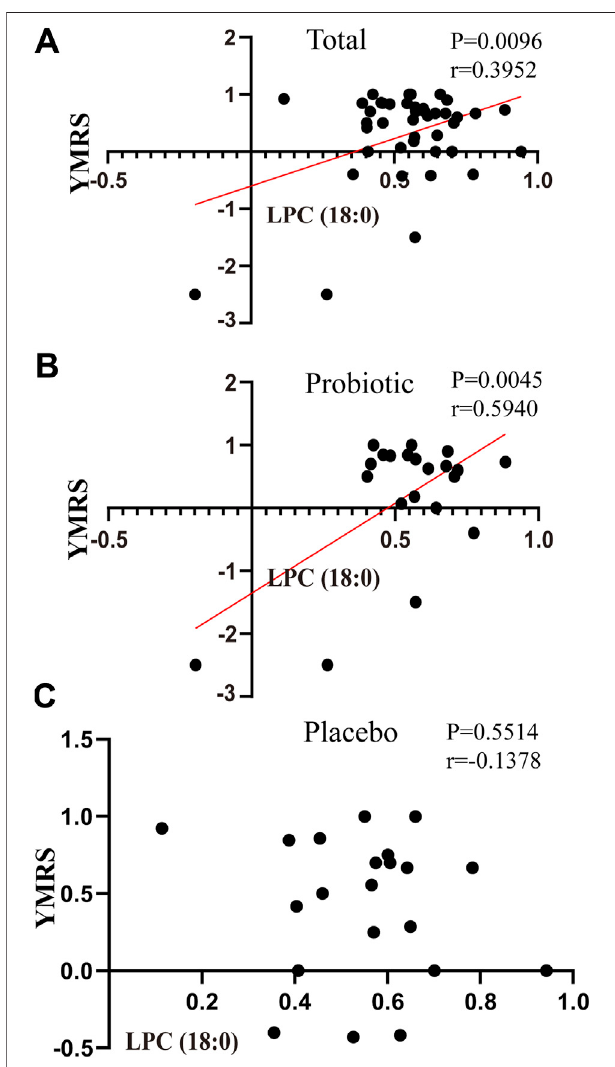
FIGURE 3 | Correlations between the changes in oxidative stress-related markers and scales in placebo and probiotic groups after treatment. (A) the association between YMRS and LPC (18:0) in bipolar patients as a whole; (B) the association between YMRS and LPC (18:0) in the probiotic group; (C) the association between YMRS and LPC (18:0) in the placebo group. Abbreviations: LPC, Lysophosphatidylcholines; YMRS, young manic rating scale.